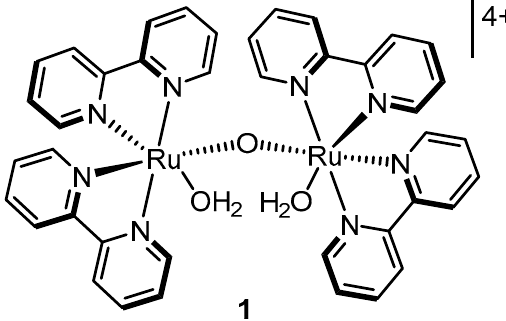
Figure 3. Molecular structure of the “blue dimer”.